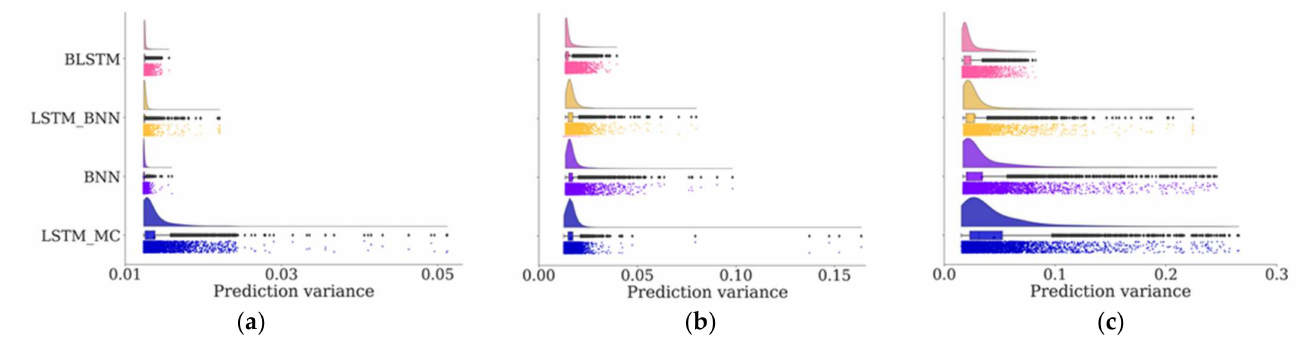
Figure 13. Kernel density estimation plots of daily streamflow prediction of all models in case study II for ( a ) forecast horizon 1, ( b ) forecast horizon 7, and ( c ) forecast horizon